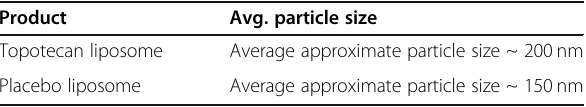
Table 8 Summary of internal pH determination by UV intensity using pyranine